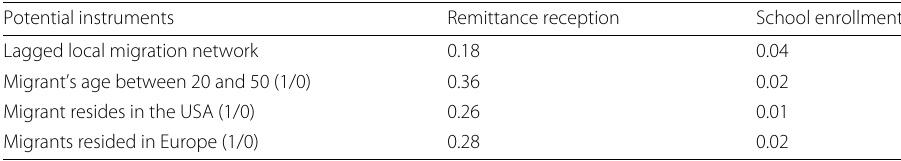
Table 6 Correlations between dependent variables and instrumental